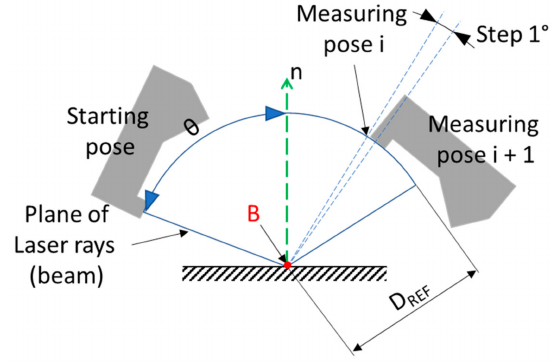
Figure 3. Schematic of the experimental measurement. D REF is the reference distance of the sensor (Z-axis), θ is the AoI of the laser rays (beams) plane relative to the surface normal (n). Point B represents the laser line (it is perpendicular to the image) around which the robot rotates the LLT sensor.